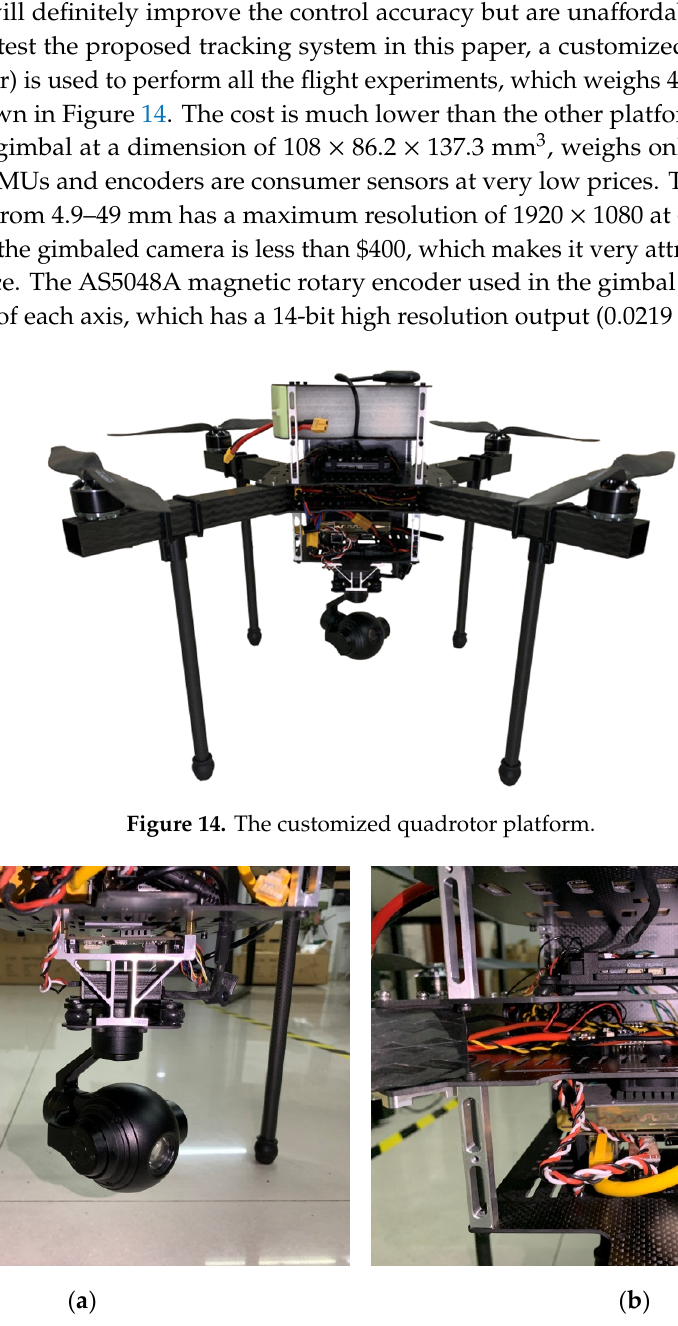
Figure 15. The gimbaled camera ( a ) and onboard equipment ( b ).